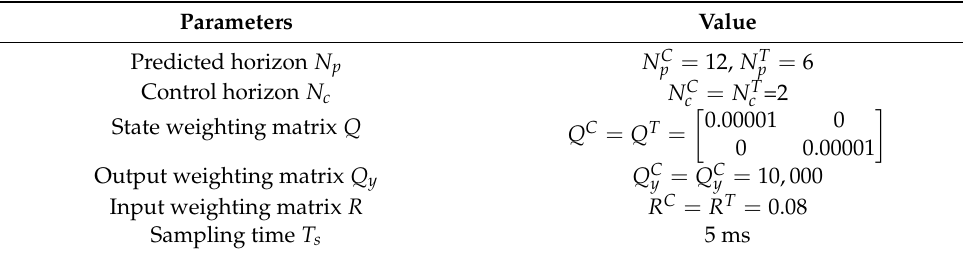
Table 2. EMPC Controller design